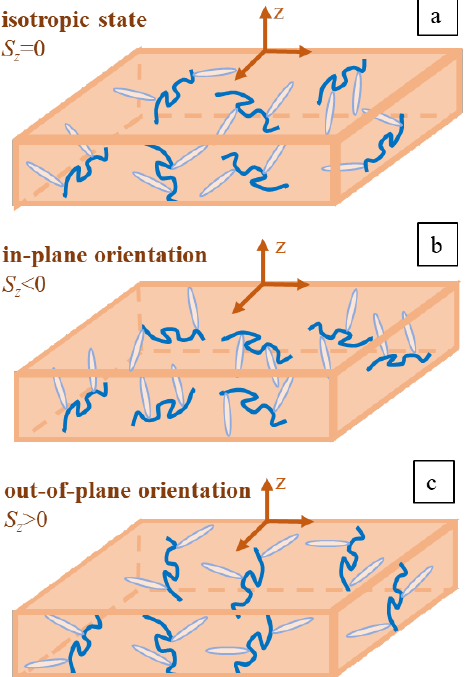
Figure 2. Three cases of initial polymer backbone orientations: ( a ) isotropic state—backbones are without preorientation; ( b ) case 1—backbones have in-plane orientation; and ( c ) case 2 corresponds to the out-of-plane backbone orientation. S z is the order parameter of polymer backbones in respect to the z -axis.